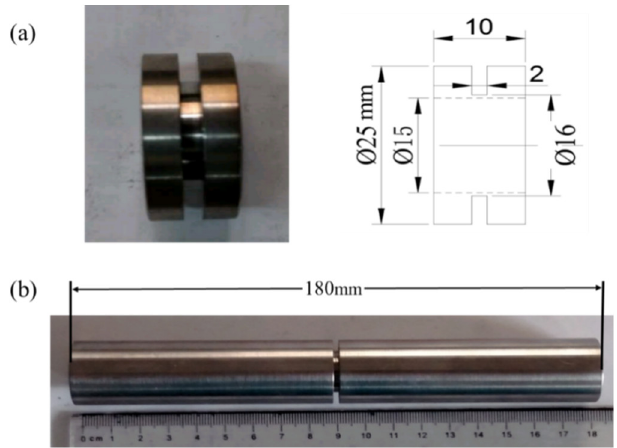
Figure 4. Scheme of the shape and size of TB6 torsional specimen: ( a ) normal-temperature specimen; ( b ) high-temperature specimen.